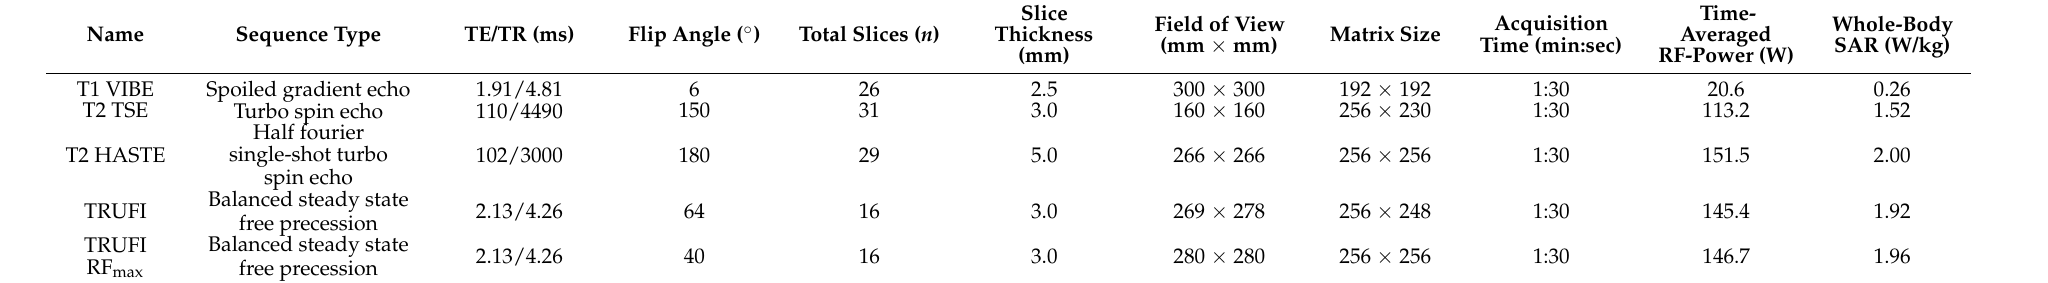
Table 1. Overview of the investigated sequence parameters for MR